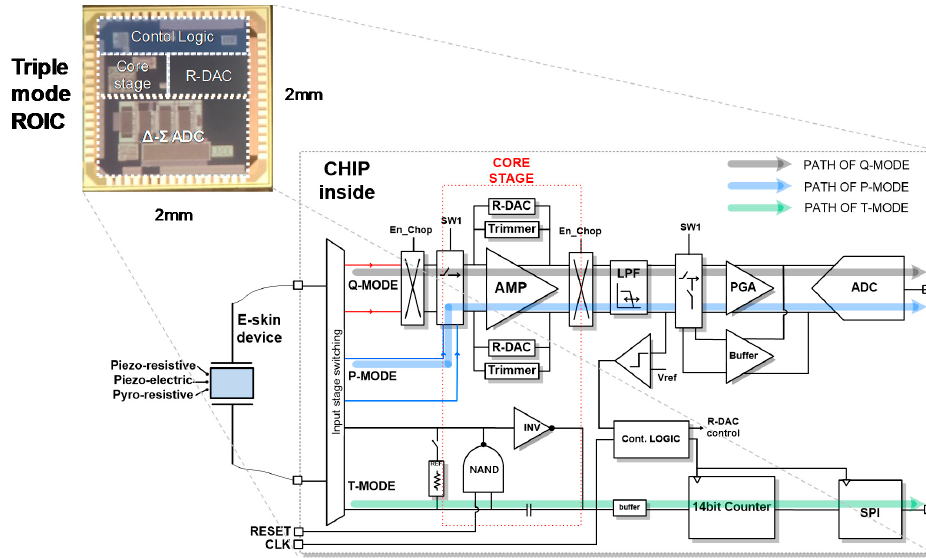
Figure 3. Block diagram of triple-mode reconfigurable readout integrated circuit (ROIC).